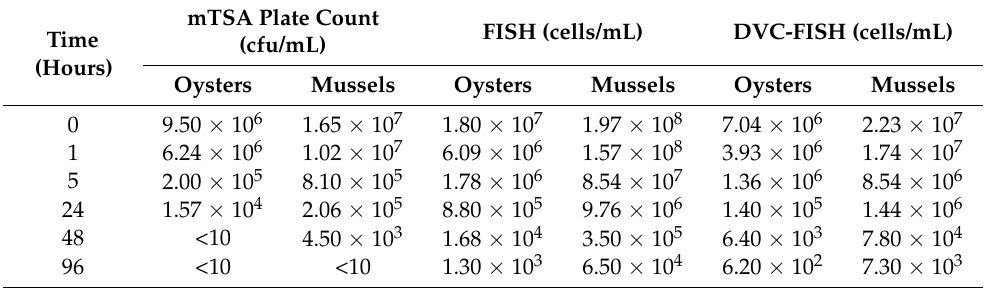
Table 4. Counts of oyster and mussel samples in refrigeration simulation at 8 ◦ C.